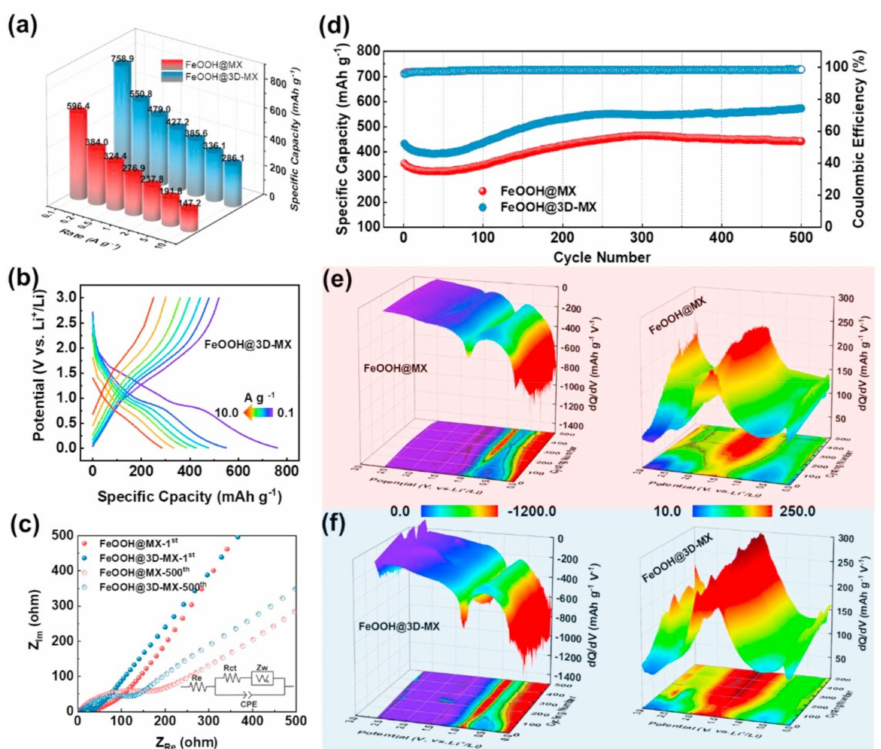
Figure 8. Electrochemical performance of FeOOH@MX and FeOOH@3D − MX electrodes for us- age in Li + storage battery: ( a ) rate properties, ( b ) the discharging and charging properties of FeOOH@3D − MX when current densities change from 0.1 to 10 A · g − 1 , ( c ) Nyquist plots (the equiv- alent circuit is shown in the inset), ( d ) cyclic performance at the condition of 500 mA · g − 1 ,